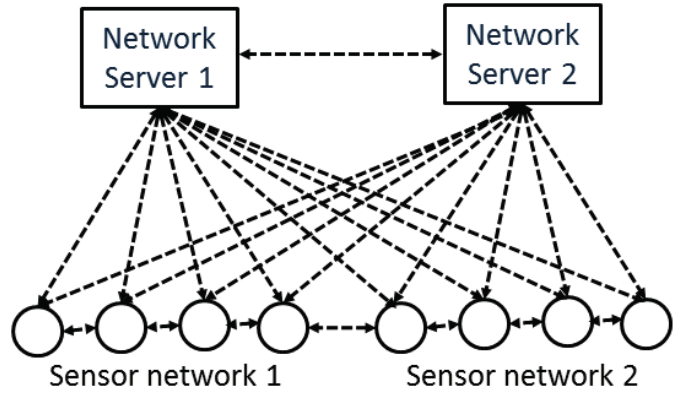
Figure 4. Interaction between two sensor